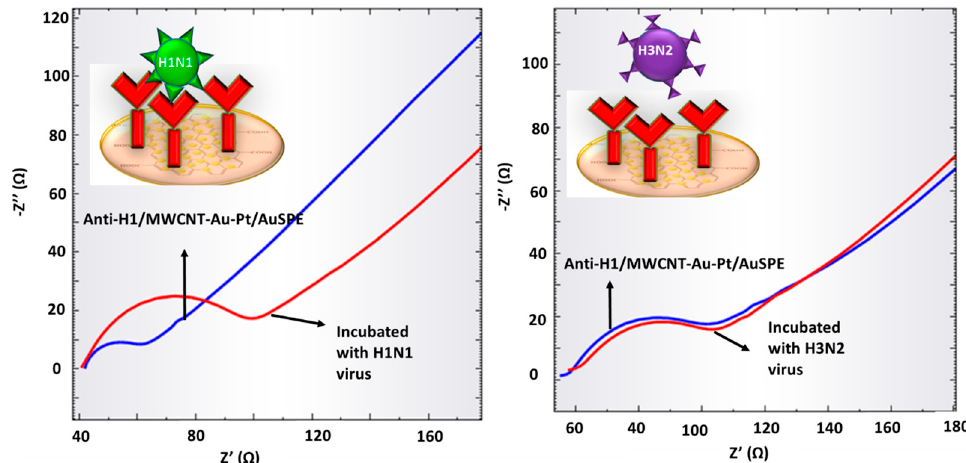
Figure 7. Obtained Nyquist plots after the incubation of H1N1 and H3N2 influenza A viruses with developed electrochemical anti-H1-based influenza A immunosensor.